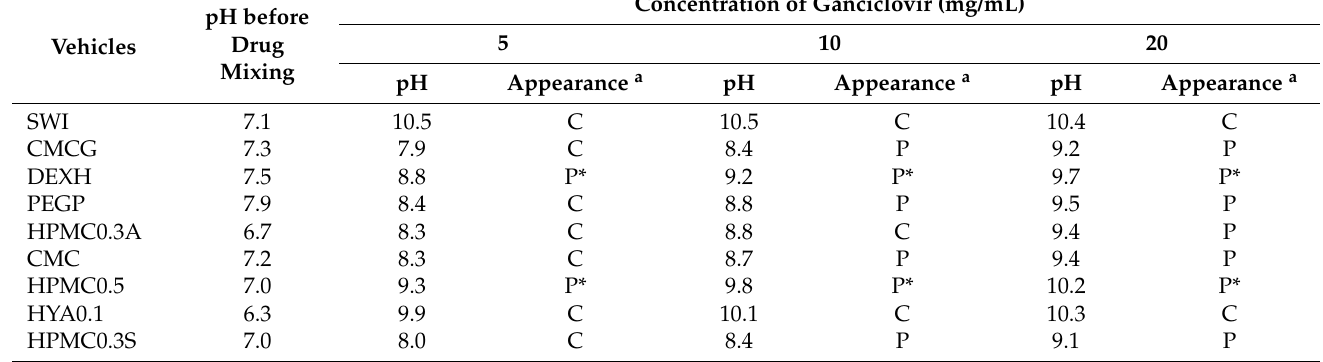
Table 3. Physical appearance and pH values of compatibility study between eight commercial artificial tears available in Thailand and ganciclovir solutions at the concentration of 5, 10, and 20